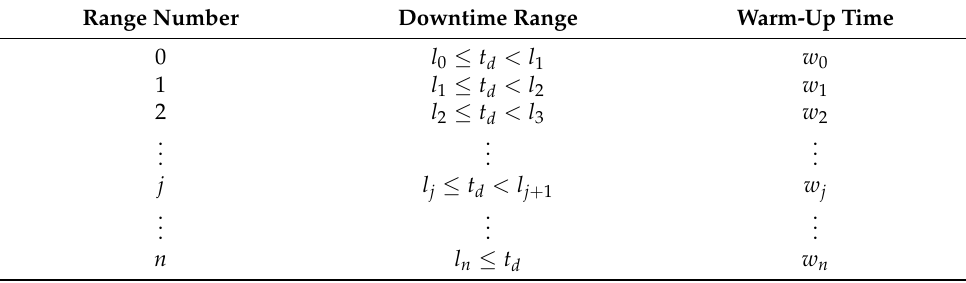
Table 2. Warm-up time diagram based on downtime length.